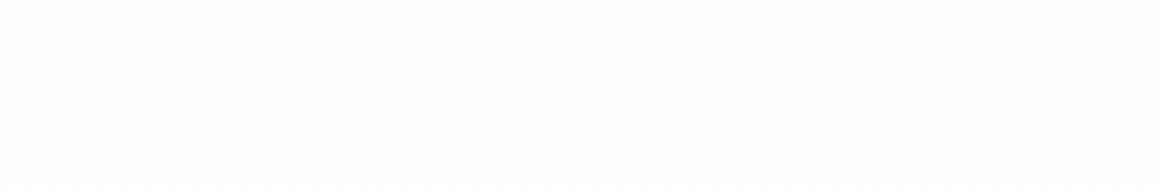
ulations. This model would also not explain